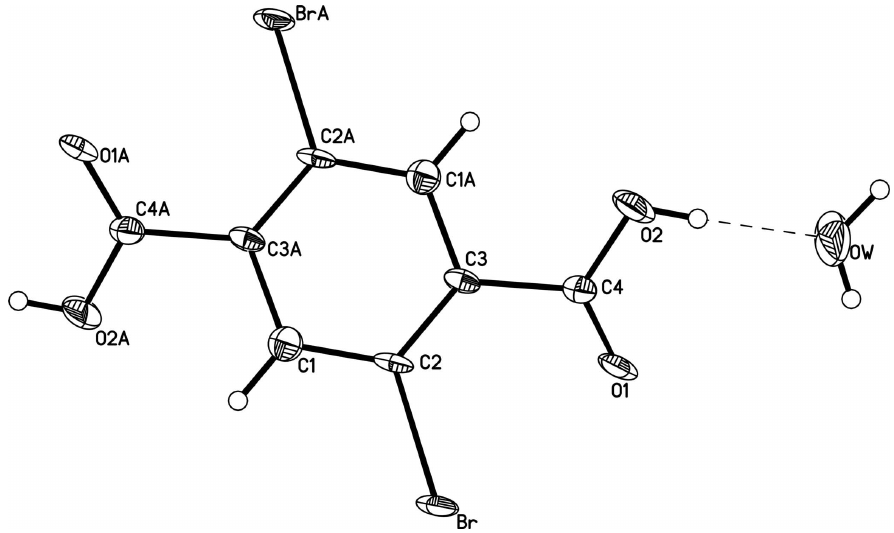
Figure 1 The molecular structure of (I), showing the atom labelling scheme. Anisotropic displacement parameters are shown at the 50% probability